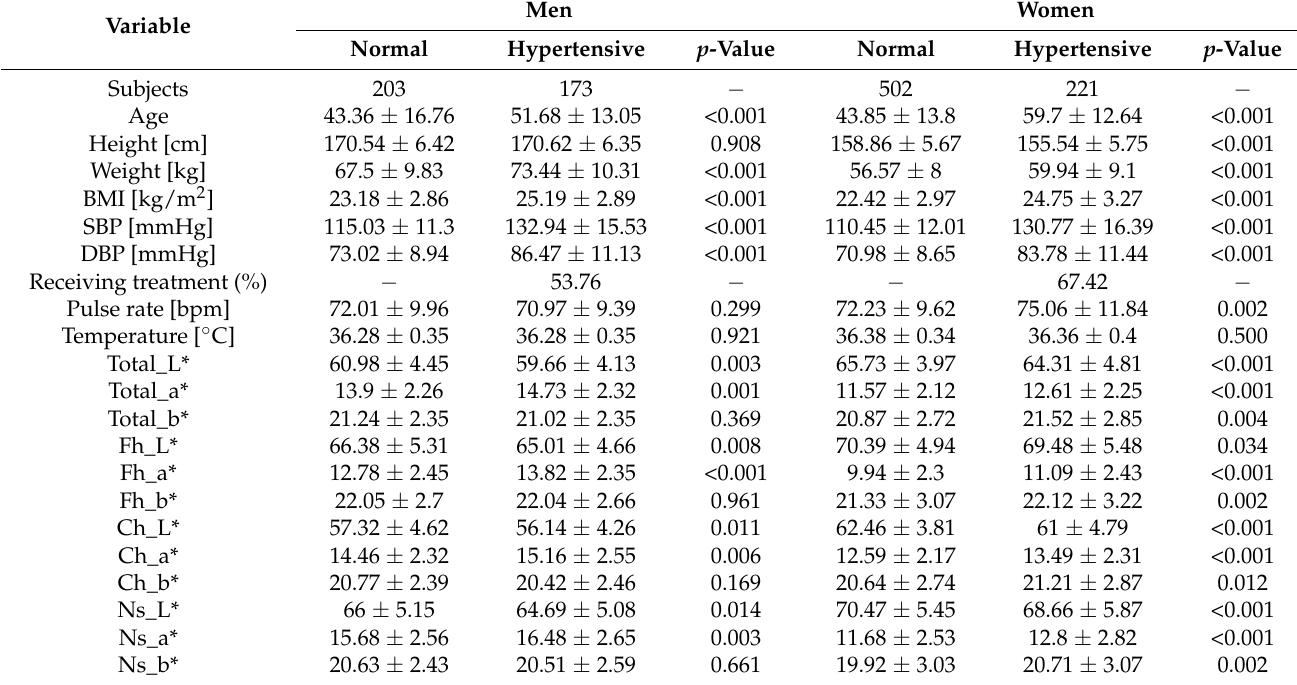
Table 2. General characteristics and complexion variables of the subjects.